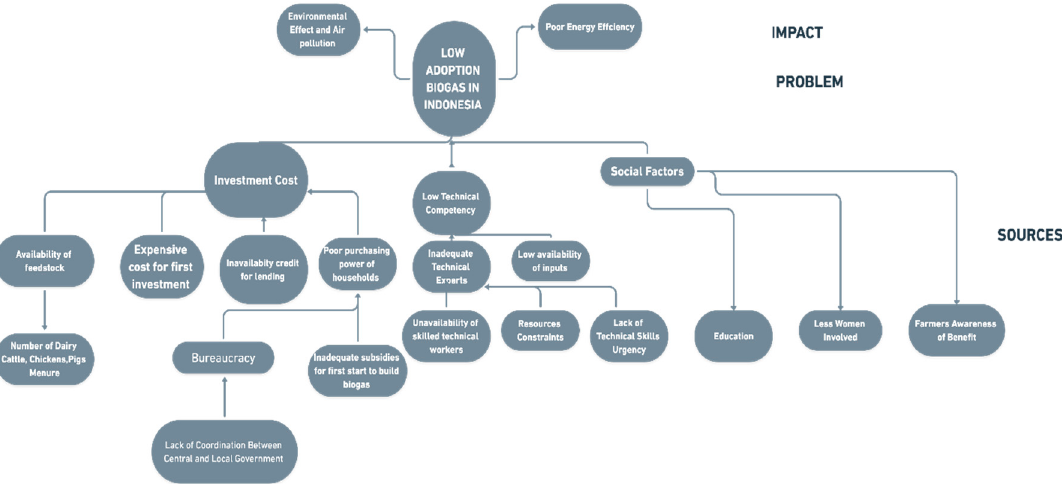
Figure 6. Logical Problem Tree of Biogas Adoption in Indonesia (created by authors, adapted from [4,15,17,32]).